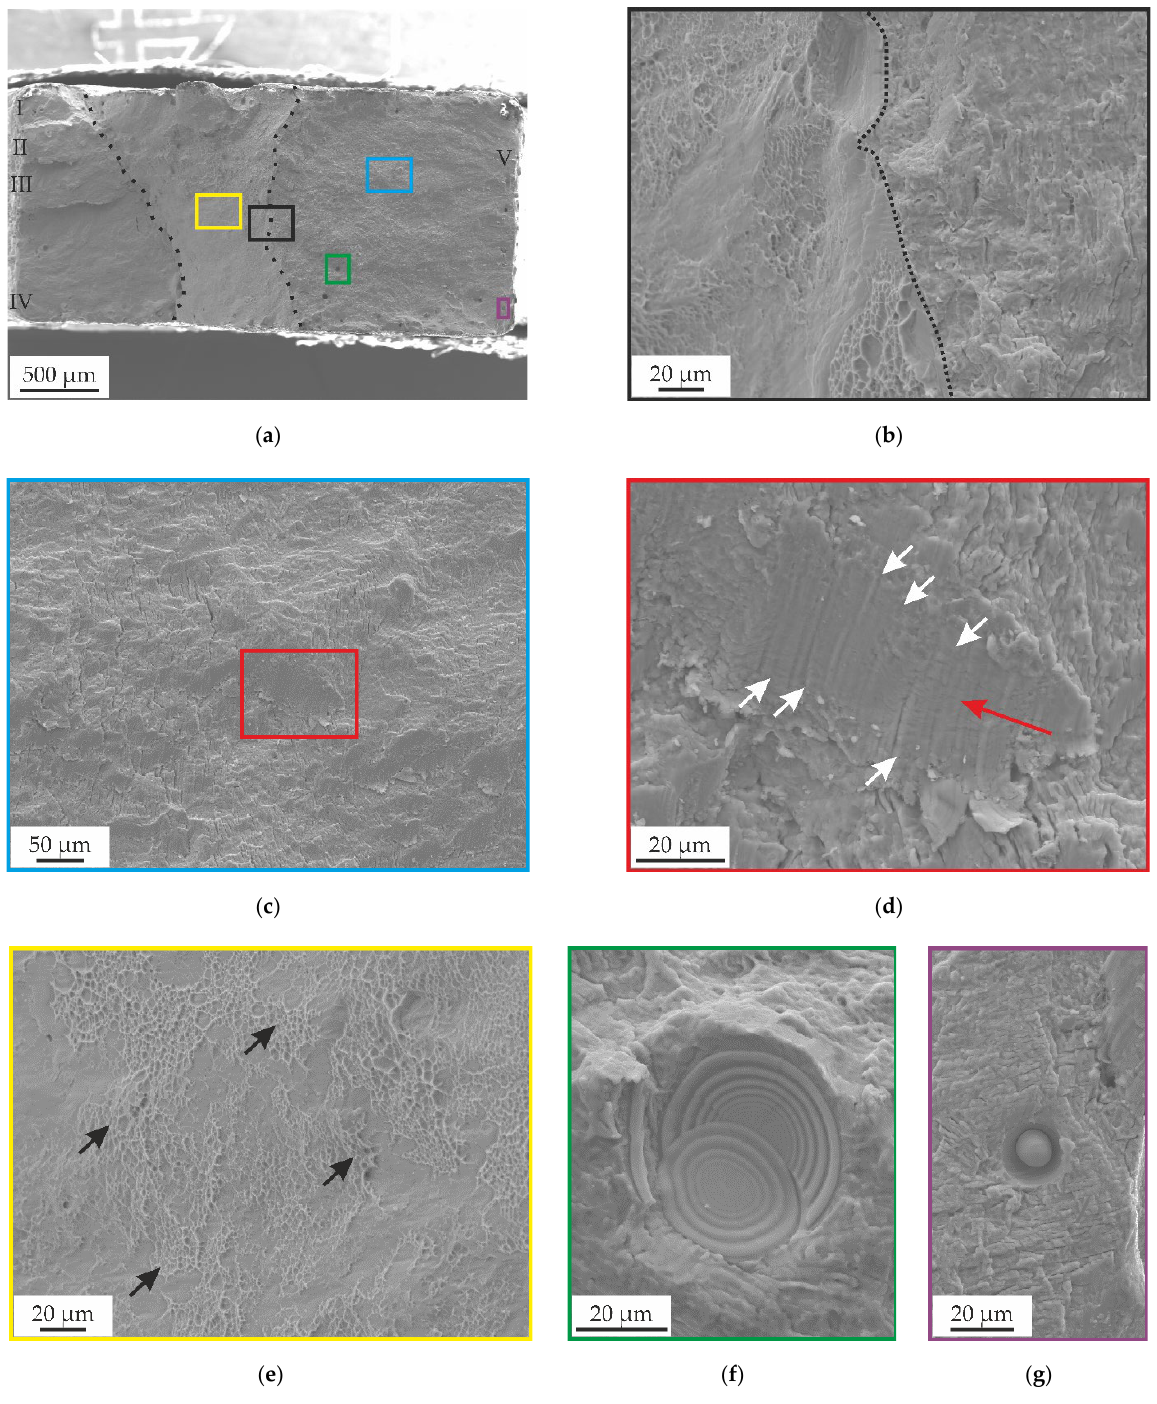
Figure 3. SEM images of a fatigue fracture surface on an as-built Ti-6Al-7Nb fatigue specimen; ( a ) overview image of the fracture surface, forced fracture occurs between the dashed, black lines; ( b ) fracture surface from the black square in ( a ), divided by the dashed line into fatigue fracture (right of the dashed line) and residual forced fracture (left of the dashed line); ( c ) fatigue fracture surface from the blue square in ( a ); ( d ) detailed view of the red square in ( c ) of the fatigue striations (white arrows) and the probable crack propagation direction (red arrow); ( e ) detailed view on the residual forced fracture surface with shallow dimples (black arrows) resulting from ductile material behavior; ( f ) laser powder bed fusion (LPBF) characteristic gas pore; ( g ) LPBF characteristic lack of fusion defect with unmelted powder particle.